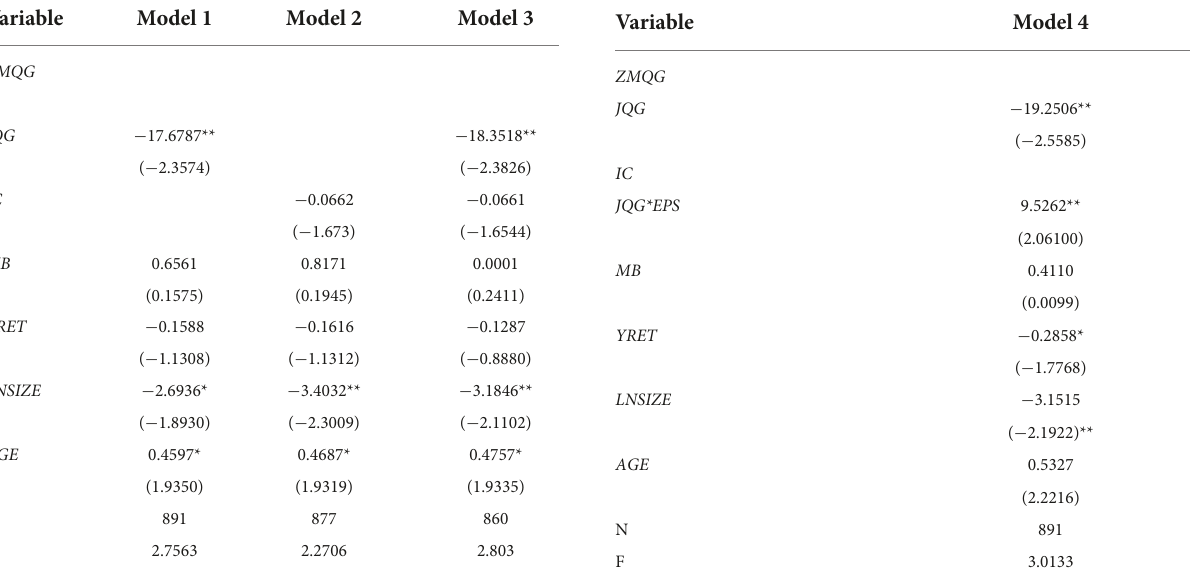
TABLE 6 Regression results of the mediating effect of investor confidence.